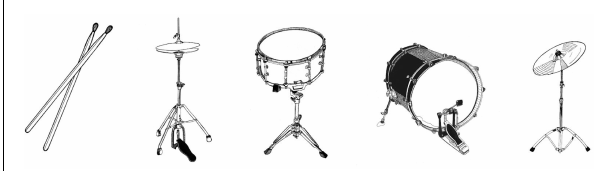
FIGURE 3 | From left to right: Rimshot, Hi-hat, snare drum, kick drum, and cymbal. When the picture is displayed, the patient is invited to imitate his/her interpretation of the sound made by the instrument. Thanks to a visual input only, the patient is freer to explore his or her expression without having been influenced by someone else’s